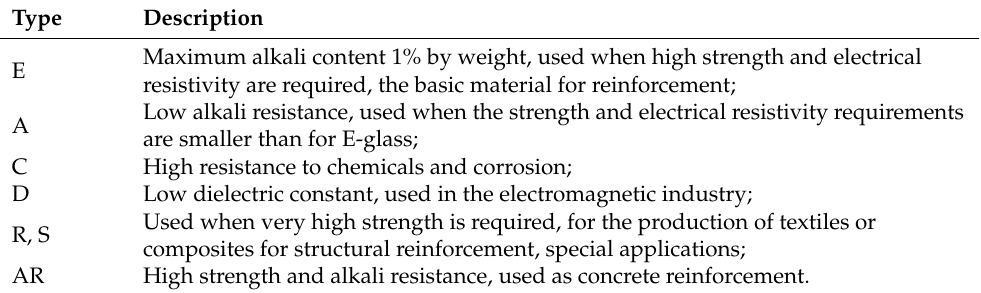
Table 1. Types of glass fibers